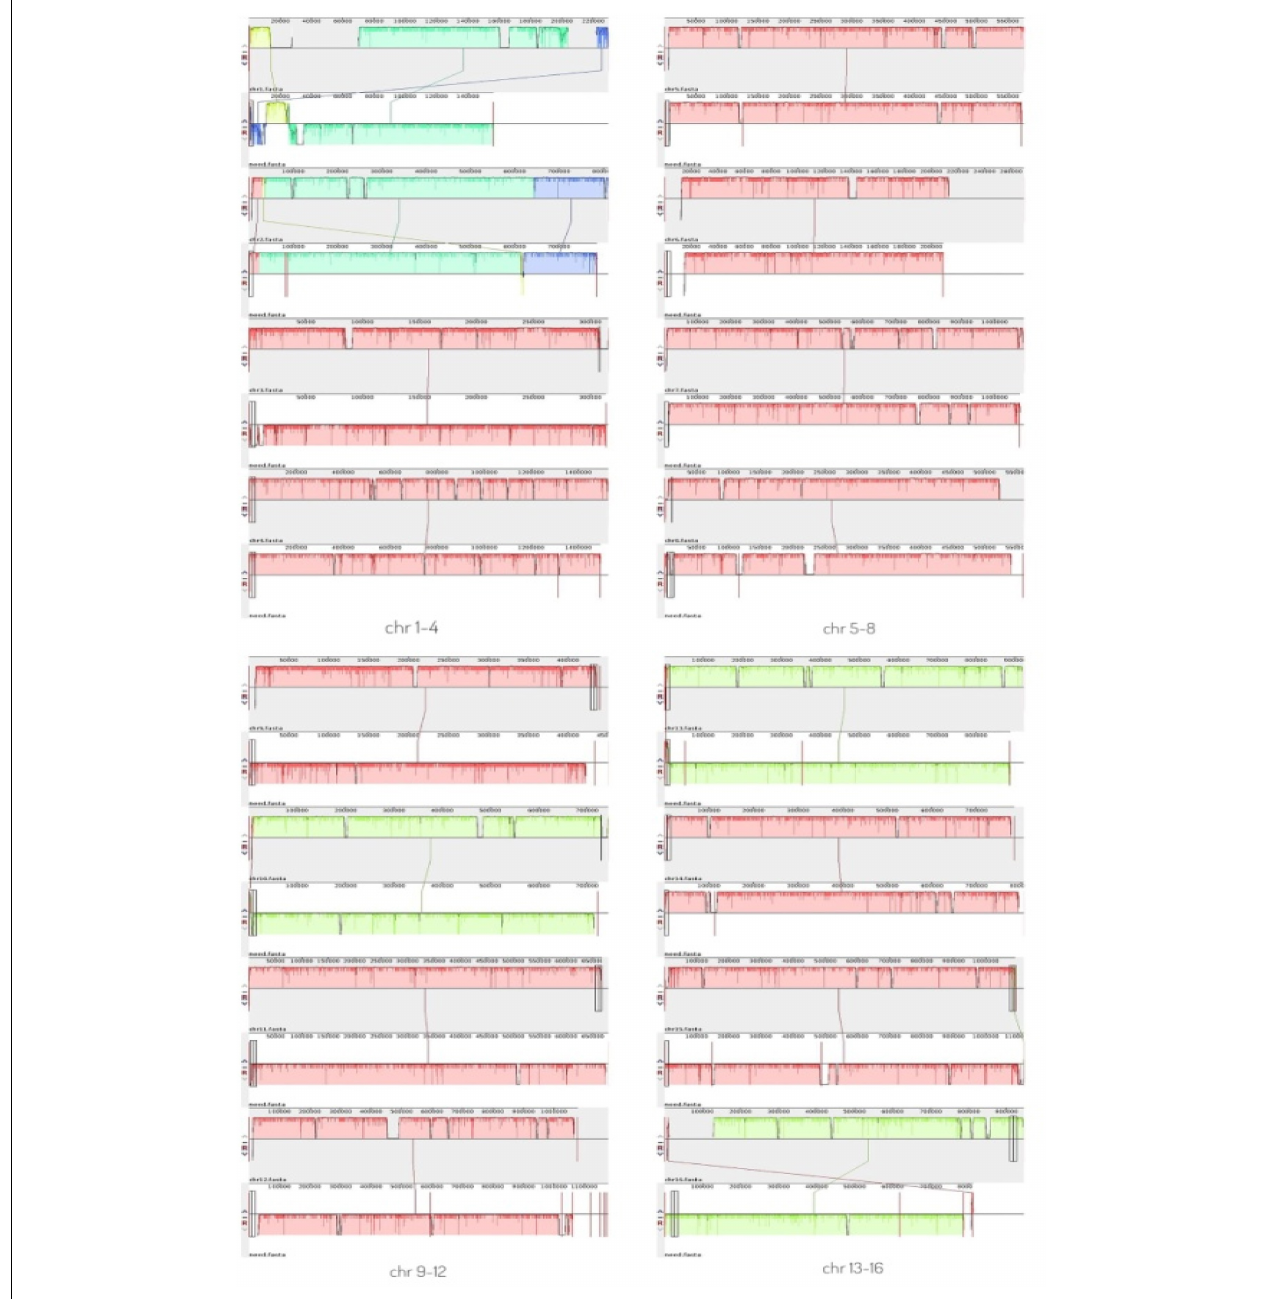
FIGURE 2 | Mauve analysis on 16 chromosomes between the genome of strains JH301 and S288c. The top bar shows the chromosome of strain JH301; the bottom bar shows the chromosome of strain S288c.